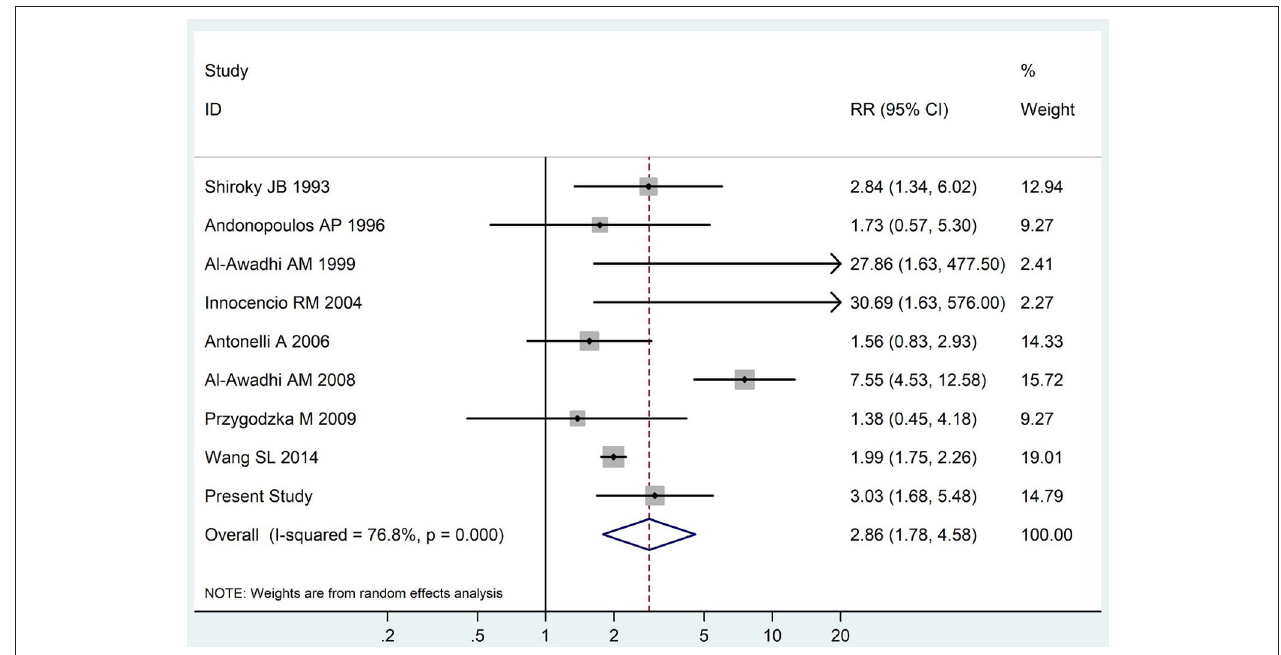
FIGURE 2 | Forest plot for the increased risk of thyroid dysfunction among RA patients (The diamond represents the pooled RR and 95% CI).